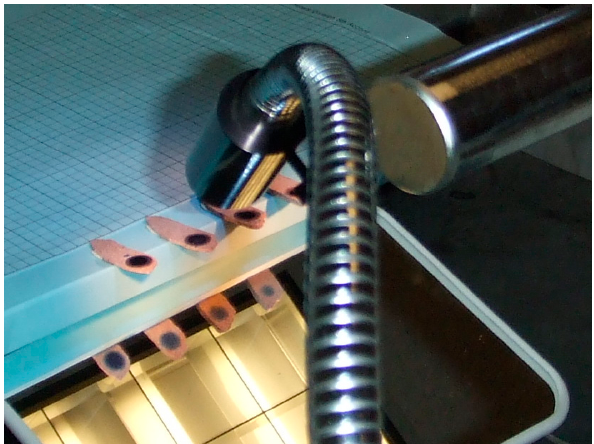
Figure 3. Experimental setup to permit simultaneous observation of ink applied to tops of slabs and image in mirror, angled below, of breakthrough ink on the undersides of slabs. Metal gooseneck piece in foreground is a high-intensity lamp.